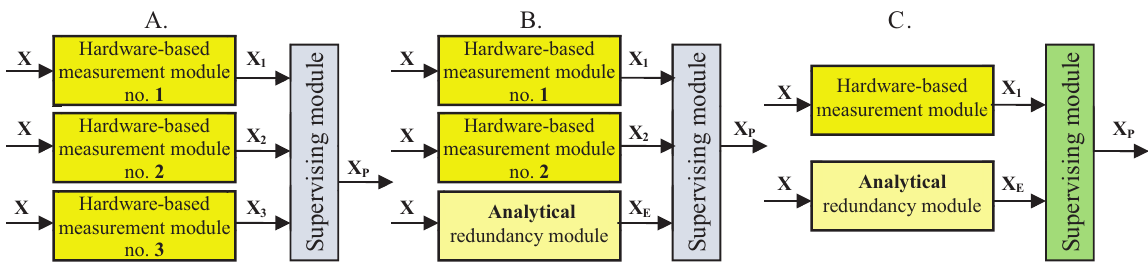
measurement module no. 3 Figure 1. Block diagrams of typical measurement system redundancy solutions, where: X – physical state variables, X 1 , X 2 , X 3 – measurement vectors, X E – estimated measurement vector, X P – output measurement vector (Dołęga et al.,